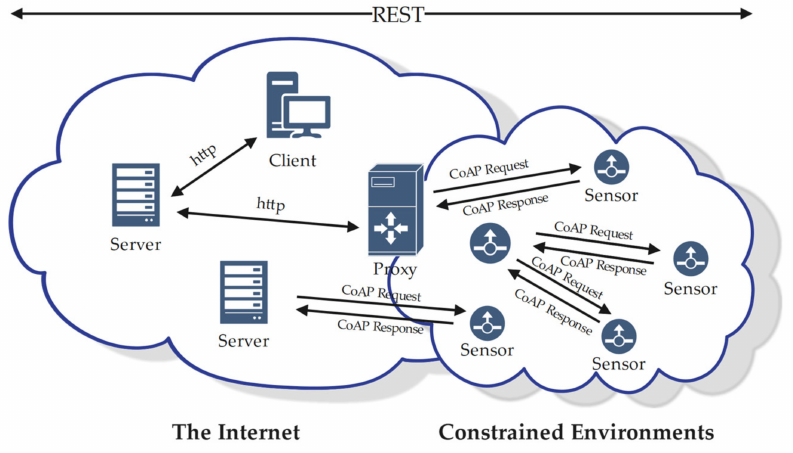
Figure 1. Network framework of